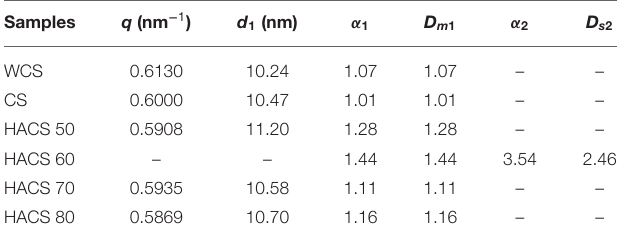
TABLE 5 | SAXS parameters of different samples.